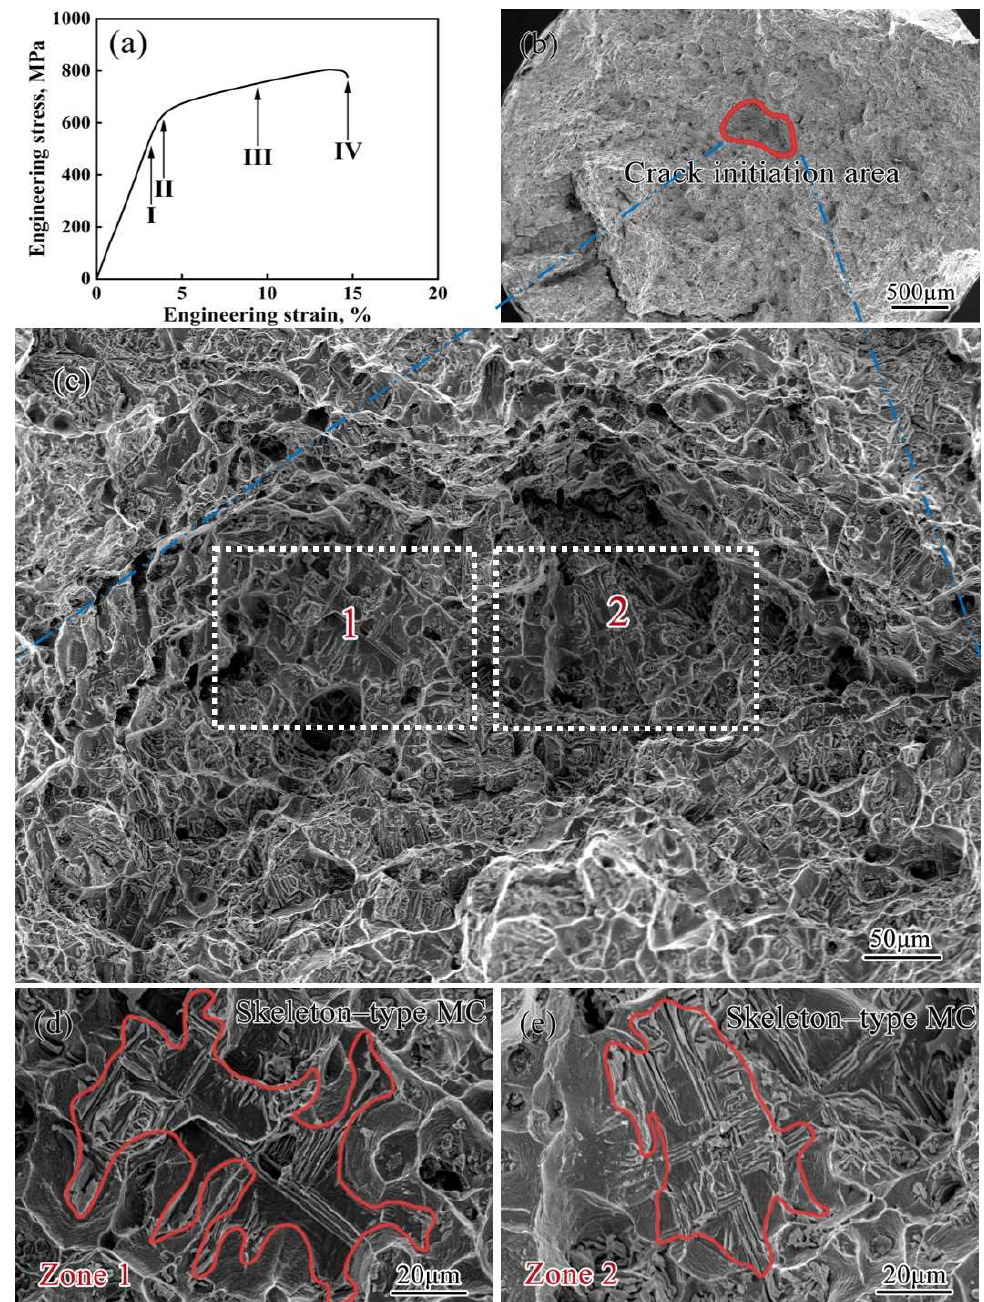
Figure 4. Stress-strain curve and fractography of the tensile specimen. ( a ) The stress-strain curve shows good plasticity. ( b ) It shows a ductile fracture morphology. ( c ) Two abnormal-sized dimples (marked with 1 and 2) exist in the crack initiation area. ( d , e ) Two huge skeleton carbides are observed embedded in the